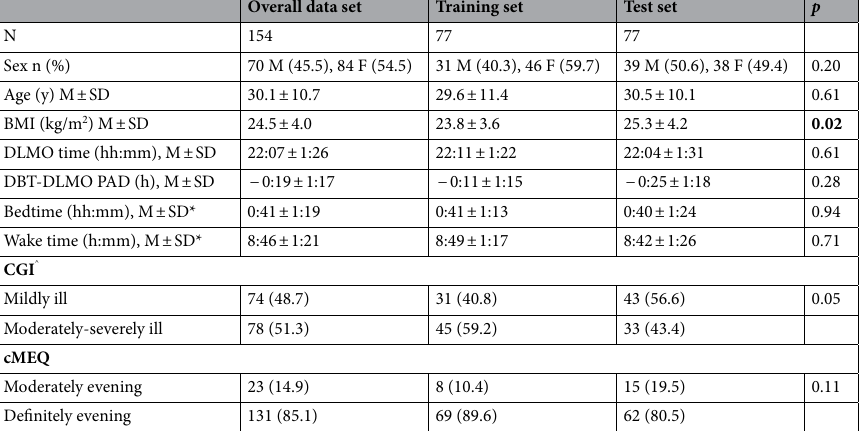
Table 1. Participant characteristics of the overall, training and test datasets. BMI = Body Mass Index, DLMO = Dim Light Melatonin Onset, DBT-DLMO PAD = Desired Bedtime –Dim Light Melatonin Onset Phase Angle Difference, CGI = Clinical Global Impressions scale, cMEQ = Composite Morningness- Eveningness Questionnaire; Data is represented as mean ± SD. *Average objective bed and wake times over 5–7 days. ˄ Reduced